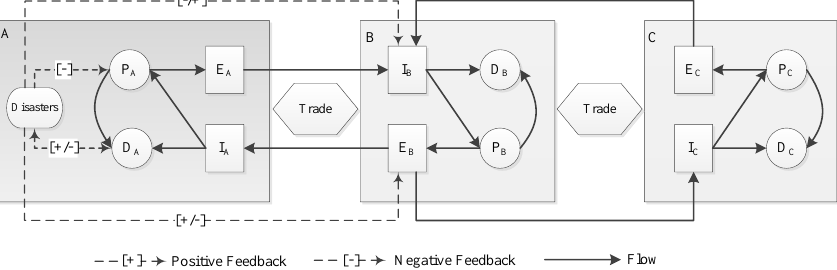
Figure 1. Interactions between disasters and trade system. P i denotes production of region i , D i demand, I i import value, and E i export value. Solid arrows indicate flow between two components and dashed arrows indicate the